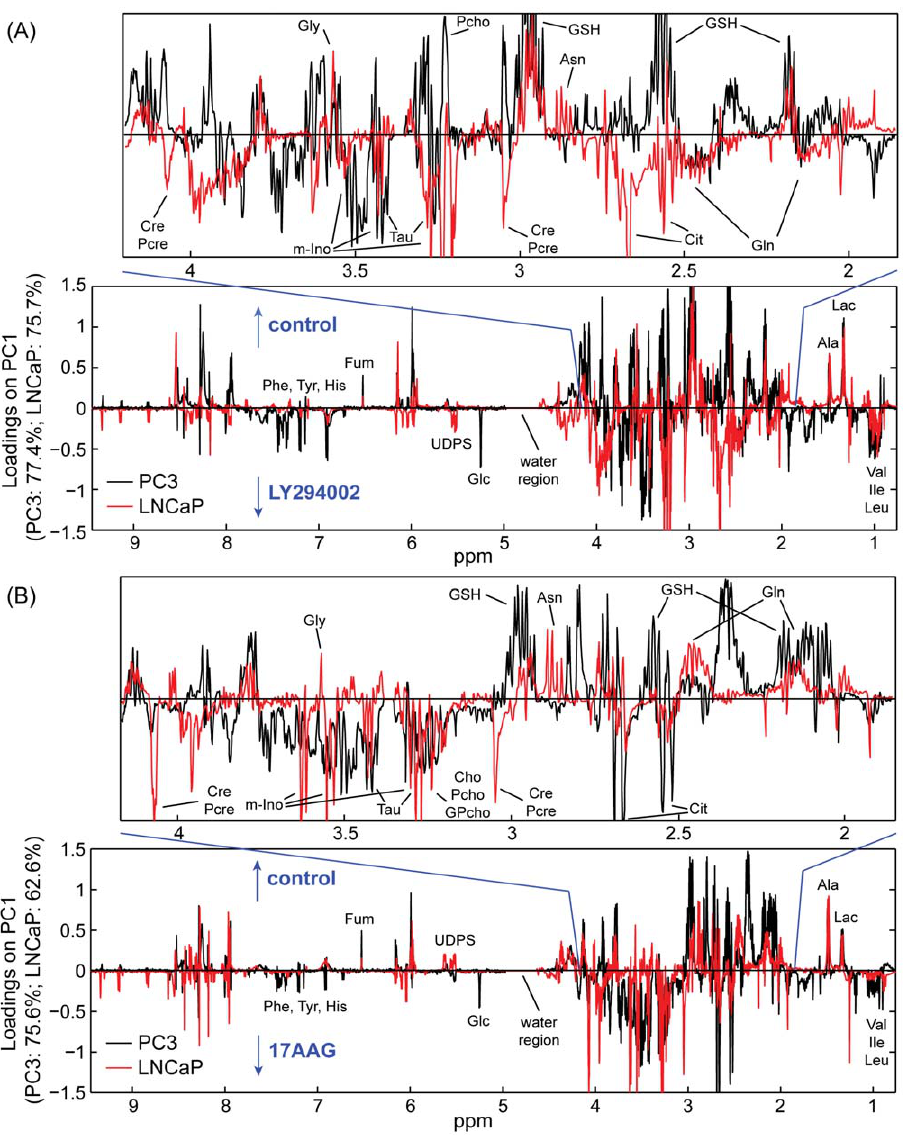
Figure 4. Multivariate statistical analysis of the MR spectra. Loadings plots (on PC1) obtained by performing the PCA comparisons on the MR spectra of control and one treatment per analysis (as shown in Fig. 3) acquired on polar extracts of PC3 (black line) and LNCaP (red line) prostate cancer cells following 48 hours of treatment with (A) LY294002 or (B) 17AAG. Enlarged sections of the loadings plots represent the region of 1.9–4.1 ppm. Ala: alanine; Asn: asparagine; Cho: choline; Cit: citrate; Cre: creatine; Fum: fumarate; Glc: glucose; Gln: glutamine; Gly: glycine; GPcho: glycerophosphocholine; GSH: glutathione; His: histidine; Ile: isoleucine; Lac: lactate; Leu: leucine; m-Ino: myo-inositol; Pcho: phosphocholine; Pcre: phosphocreatine; Phe: phenylalanine; Tau: taurine; Tyr: tyrosine; Val: valine, UDPS: UDP